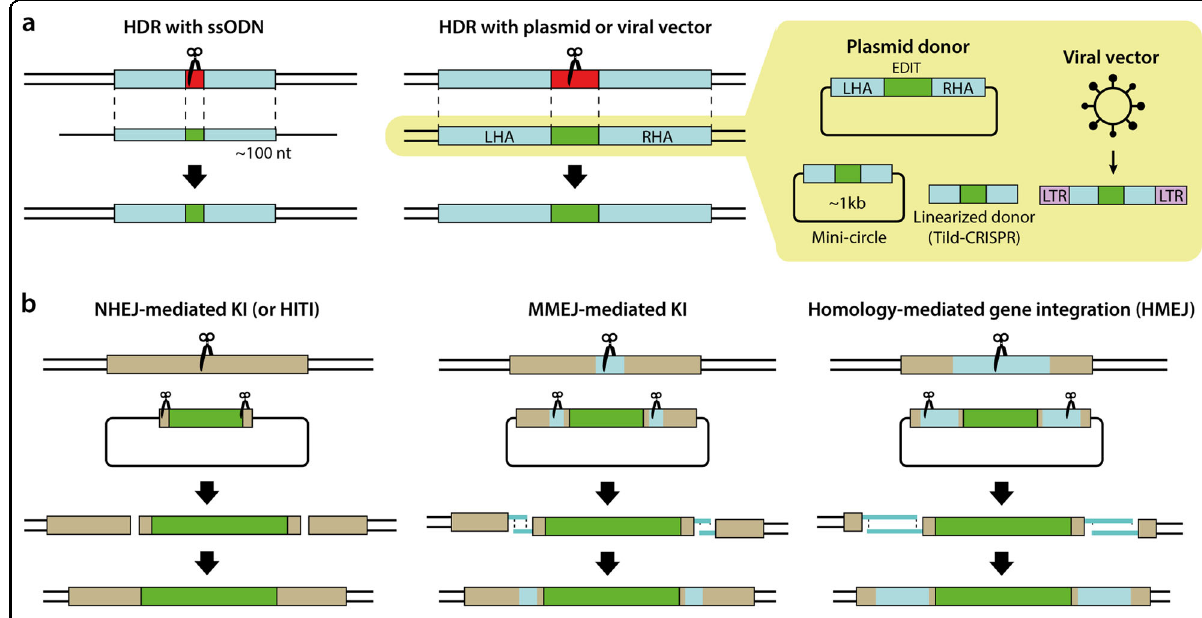
Fig. 3 Gene recovery strategies involving donor DNAs. a HDR-mediated gene correction rescue methods. b Homology-independent gene recovery methods. LHA left homology arm, RHA right homology arm, LTR long terminal